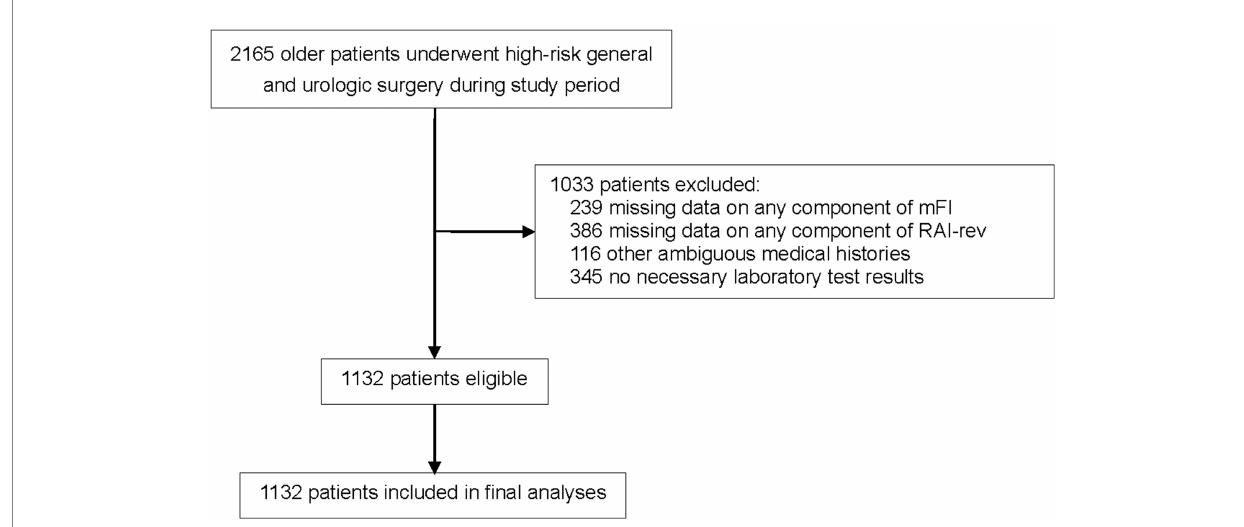
FIGURE 1 Flowchart of the study. MFI, modified frailty index; RAI-rev, revised- Risk Analysis